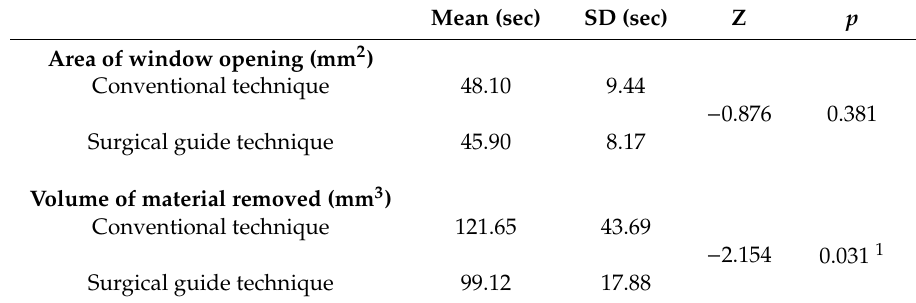
Table 2. Required area of the window opening and the volume of the material removed for supernumerary tooth